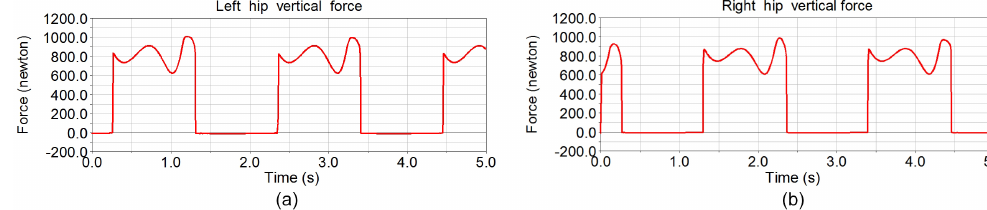
Figure 19. Computed vertical reaction force on the exoskeleton hip joint: (a) left joint; (b) right joint.